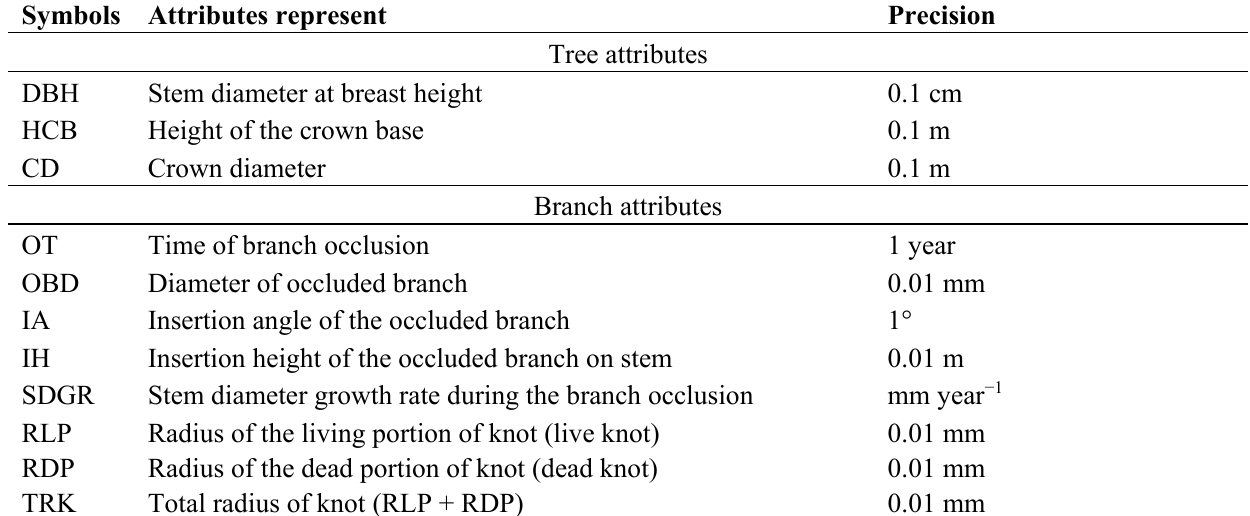
Table 1. Explanation of the